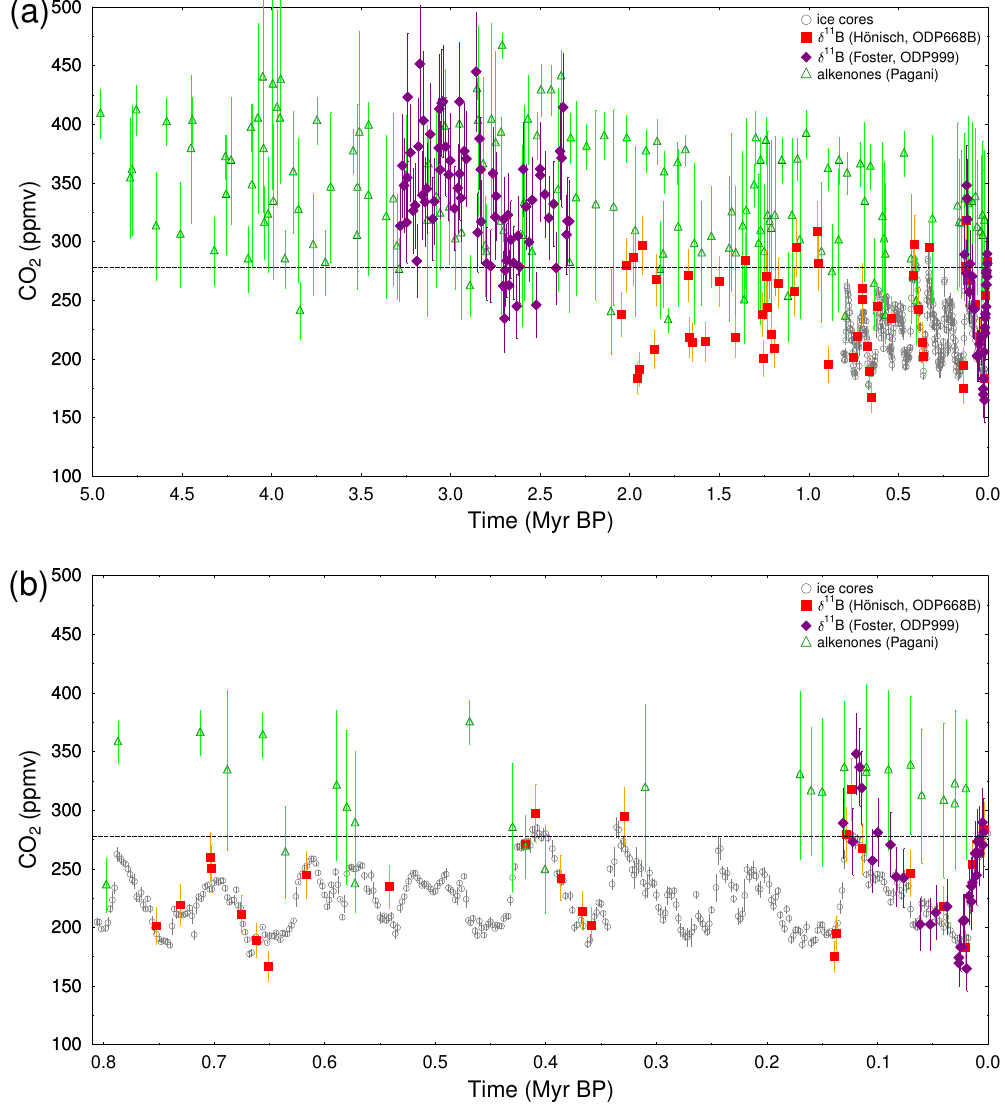
Figure 3. CO 2 data. Panel (a) : CO 2 data from ice cores based on the stack of Bereiter et al. (2015) consisting of data from Law Dome, EPICA Dome C, West Antarctic Ice Sheet Divide, Siple Dome, Talos Dome, EPICA Dronning Maud Land, and Vostok (resampled to time steps of 2kyr) and based on either δ 11 B (Hönisch et al., 2009; Foster, 2008; Martínez-Botí et al., 2015) or alkenones (Pagani et al., 2010; Zhang et al., 2013) from the three labs, Hönisch, Foster, and Pagani. Panel (b) : zoom-in on the time period covered by ice core data (last 0 .